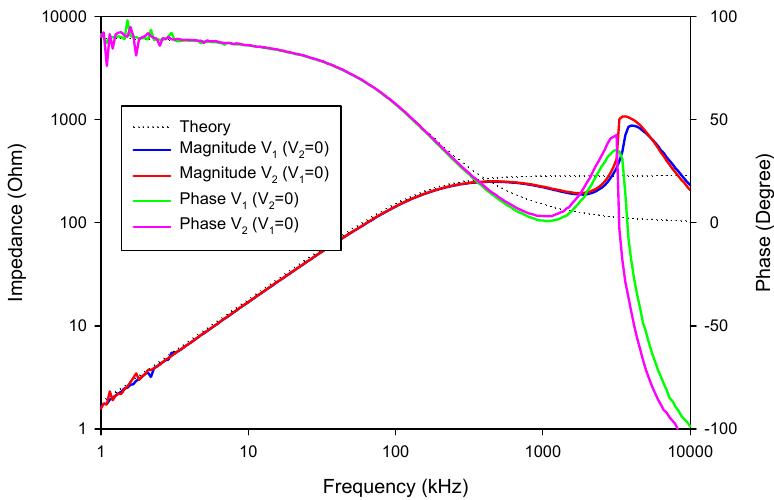
Figure 37. The experimental frequency responses of the series L-R connection with different I B .